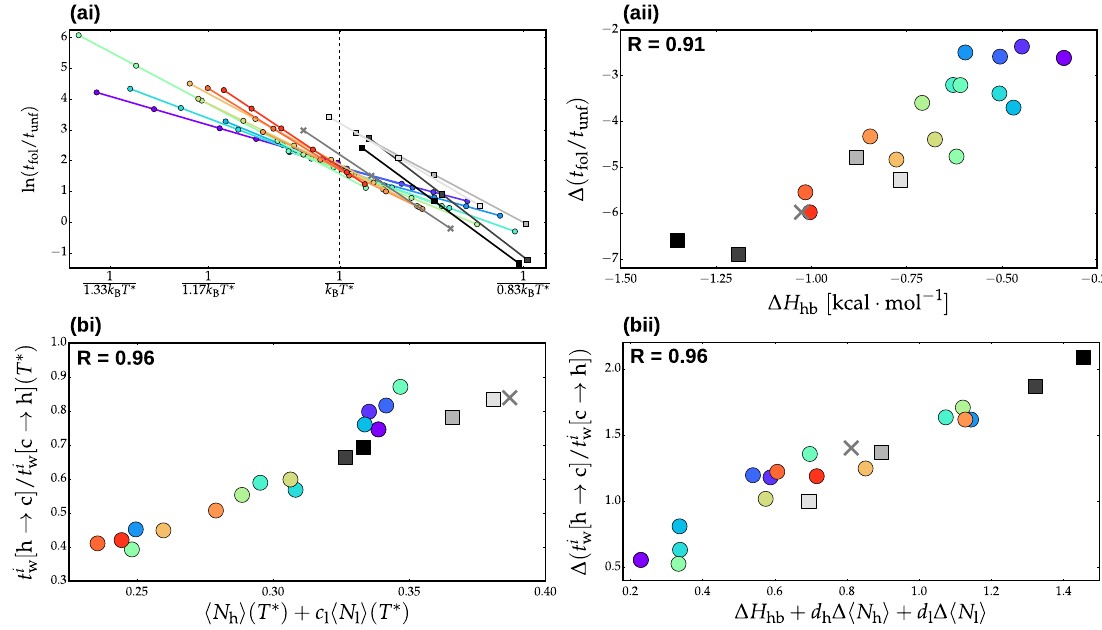
Figure 4. ( ai ) Temperature dependence of the ratio of folding to unfolding timescales, t fol / t unf . ( aii ) Slope of the linear fit of ln ( t fol / t unf ) as a function of inverse temperature versus the enthalphy of helix extension, ∆ H hb (determined as the slope of ln w ( 1/ T ) ). ( bi ) Ratio of waiting time in the helix state, t i w [ h → c ] , to waiting time in the coil state, t i w [ c → h ] , for residue position i as a function of the average fraction of helical residues, (cid:104) N h (cid:105) , and the average fraction of lone helices, (cid:104) N l (cid:105) , at T ∗ . The free parameter, c l , was determined by a fit over all models to maximize the pearson correlation coefficient, R, between the plotted quantities. Here, i corresponds to the terminal ends of the peptide (not including capping groups). ( bii ) Slope of the linear fit of ln ( t i w [ h → c ] /t i w [ c → h ]) as a function of inverse temperature versus ∆ H hb , the slope of the linear fit of (cid:104) N h (cid:105) as a function of inverse temperature, and the slope of the linear fit of (cid:104) N l (cid:105) as a function of inverse temperature. The free parameters, d h and d l , were determined by a fit over all models to maximize the pearson correlation coefficient, R, between the plotted quantities. Data from the Hy-G¯omodels are denoted with circle markers and are colored according to their relative cooperativity (as determined by ∆ f h ). The results from the PLUM models are colored in gray-scale according to ∆ H hb . The energetic reparametrizations of PLUM are indicated with square markers, while the PLUM-ent model is indicated with X